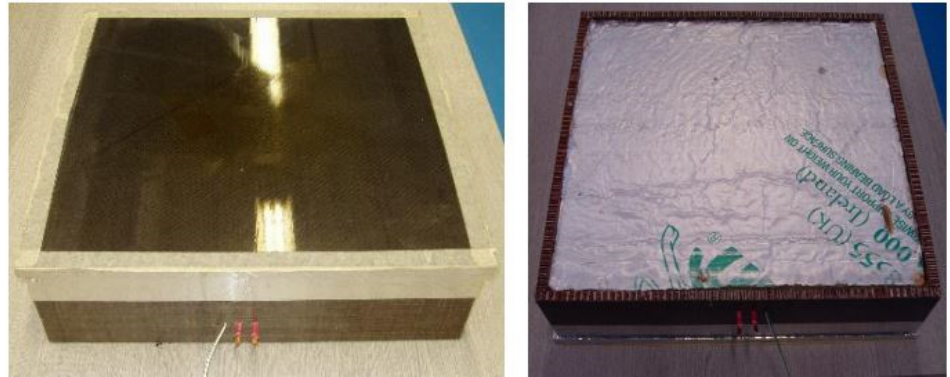
Figure 8. Heated mould tool used for cool-clave processing (acquired with permission from [18]).